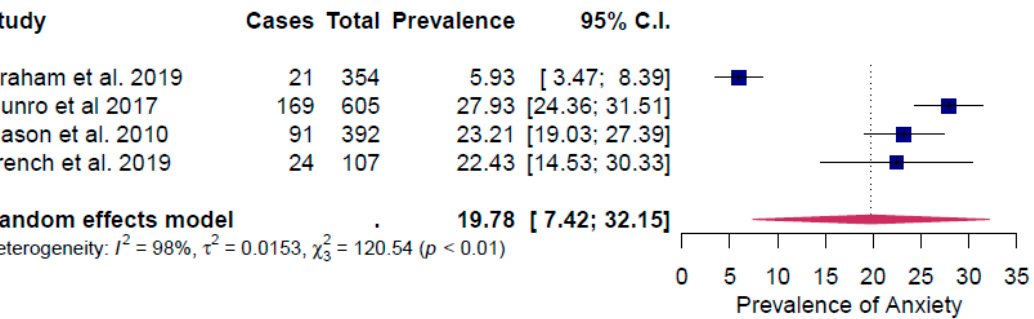
Figure 2. Forest plot of the prevalence rate of anxiety.